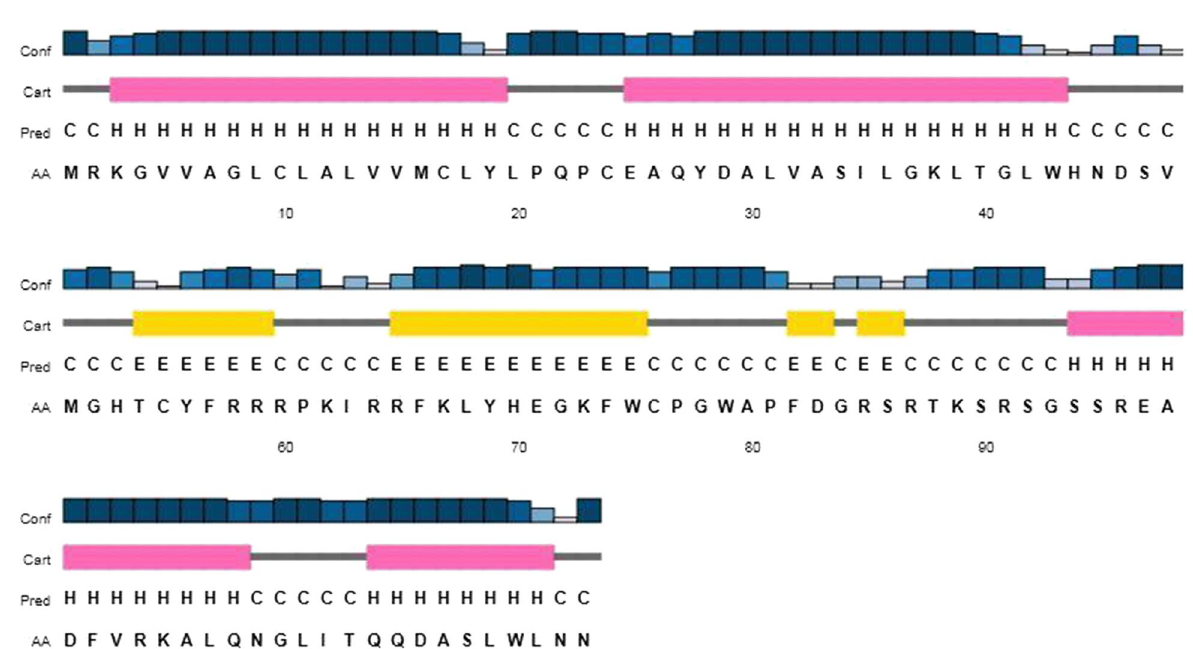
Fig. 7 Secondary structure of Pp- ALF peptide predicted using PSIPRED server. The alpha-helical structure is represented by the pink color, beta-strand by the yellow color, and the coils by the gray color, respectively